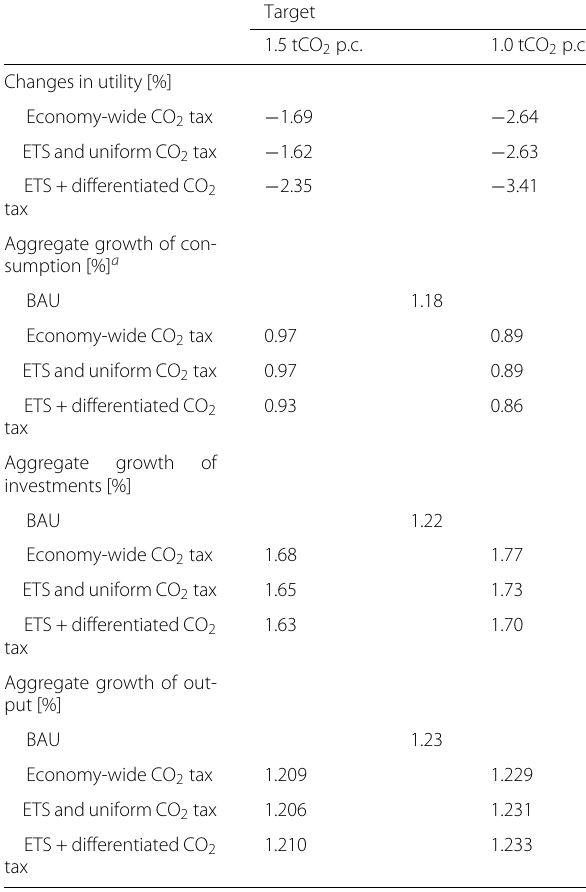
Table 3 Macro-economic effect of simulated